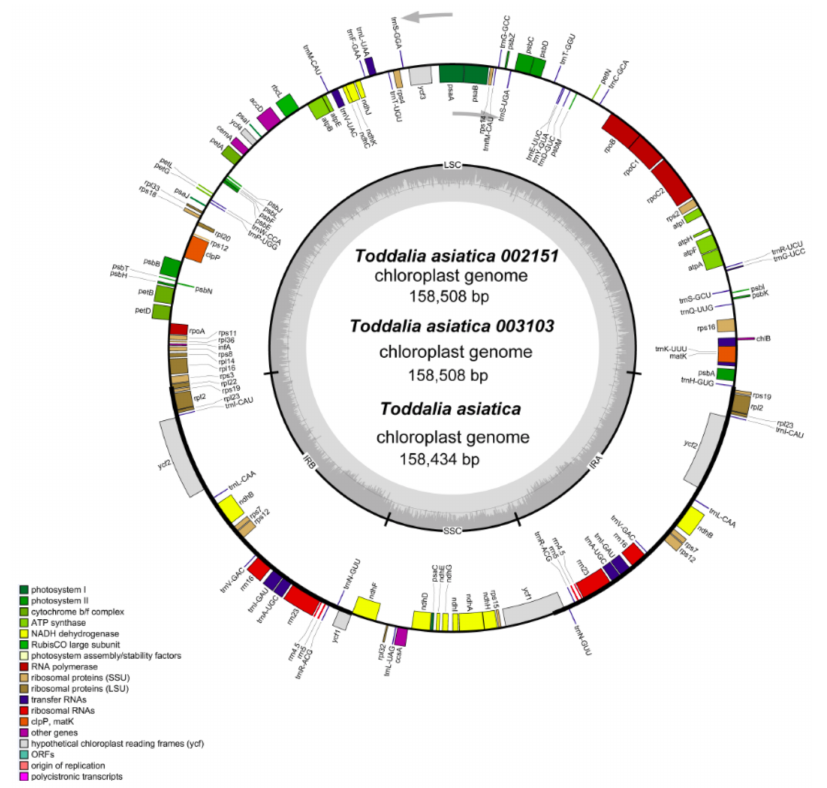
Figure 2. Gene map of Toddalia plastomes. Genes in the circle are transcribed clockwise, while the rest are transcribed counterclockwise. Dark gray shading in the inner circle indicates the GC